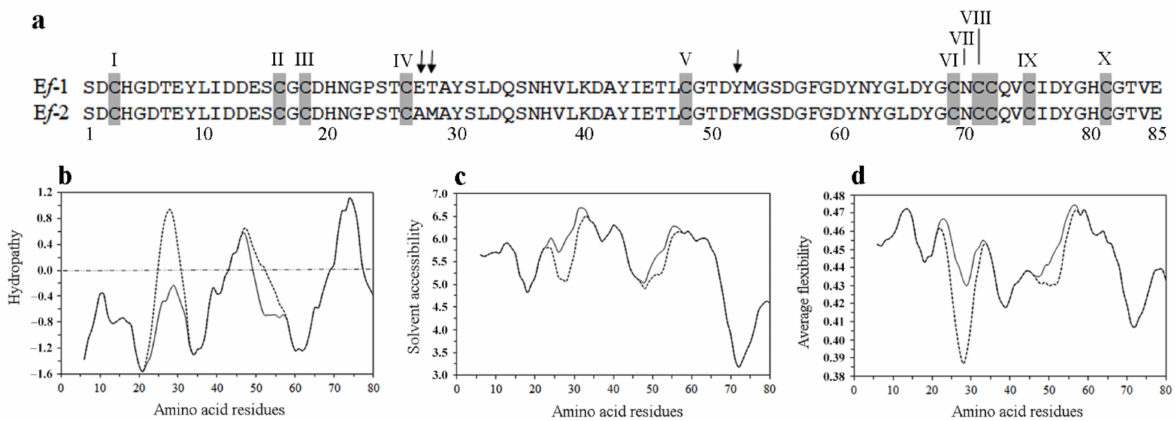
Figure 3. Amino acid sequence alignment and physico-chemical traits of E f -1 and E f -2 pheromones. ( a ) Sequence alignment with Cys residues, progressively numbered I to X, highlighted in grey and amino acid substitutions indicated by arrows. ( b ) Hydropathy, ( c ) solvent accessibility and ( d ) average flexibility plots of the E f -1 (solid line) and E f -2 (dotted line) pheromones, as generated by predictive algorithms